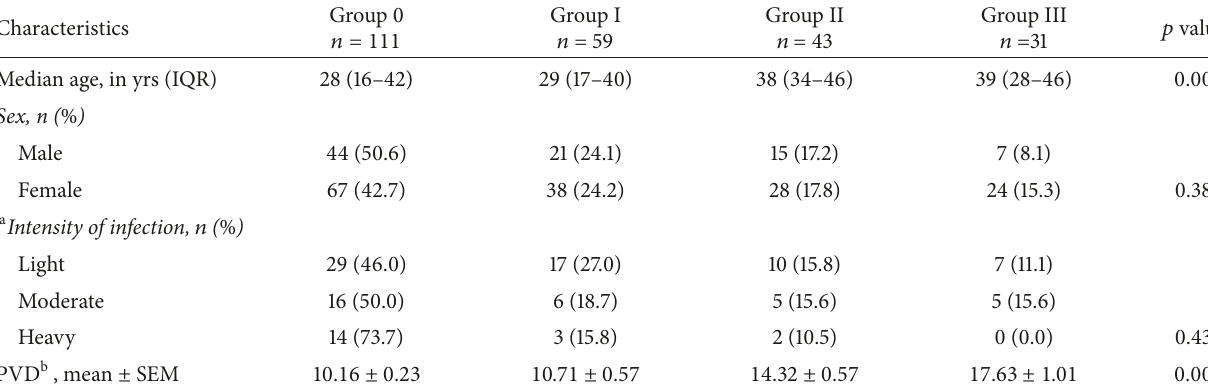
Table 1: Characteristics of study participants, by degree of hepatic fibrosis.